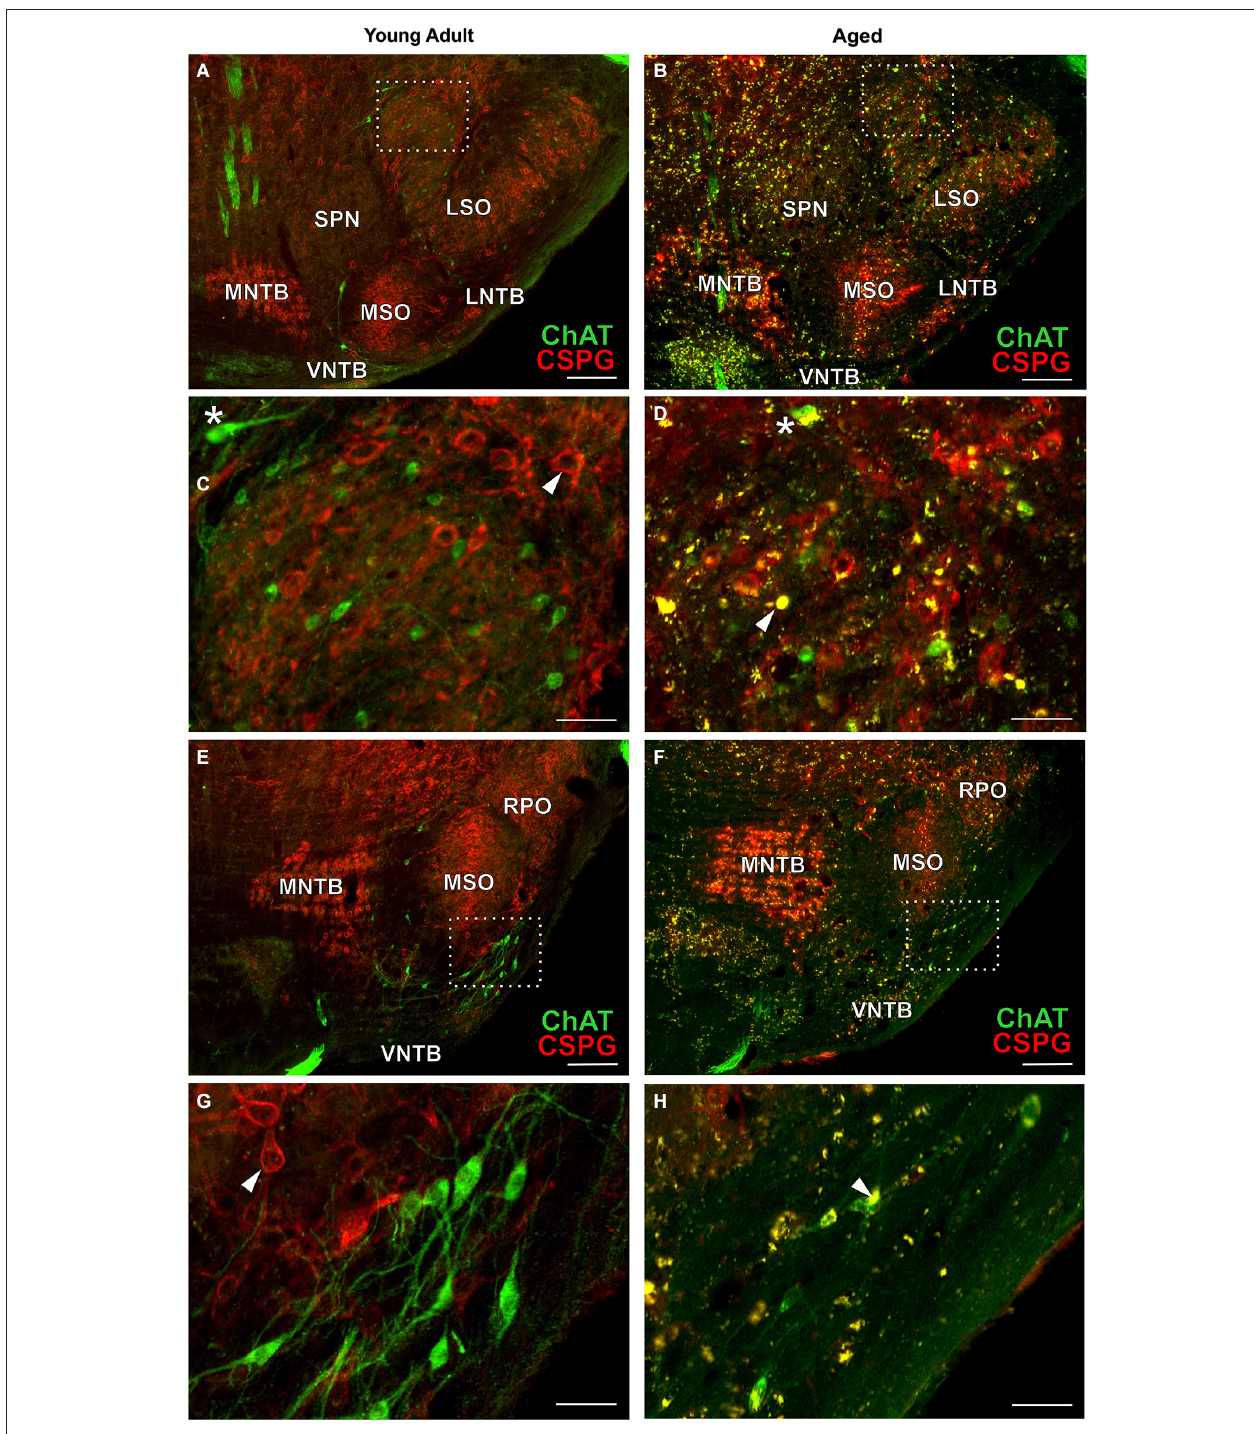
enlargement of rectangular areas in medial LSO in (C,D) . MOC neurons: section at rostral SOC (rc-level 9) in young adult and aged gerbil (E,F) . VNTB/LNTB area within rectangle in (E,F) is enlarged in (G,H) . Stars in (C,D) mark presumed MOC neurons in DPO/DLPO. The presumed MOC soma in (D) is half-filled with lipofuscin granules (yellow). Scale bar in (A,B,E,F) : 200 µ m; in (C,D,G,H) : 50 µ